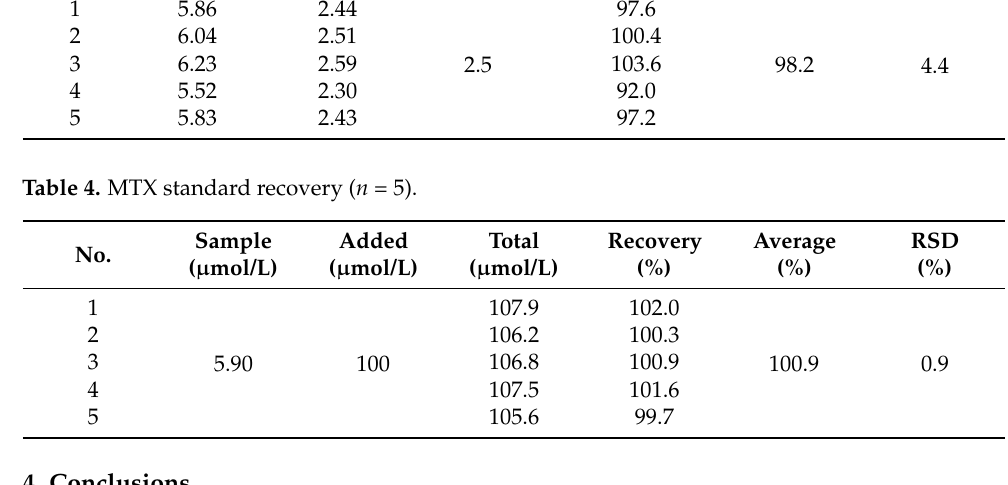
Table 3. Determination results of MTX in the pharmaceutical product ( n = 5). No.